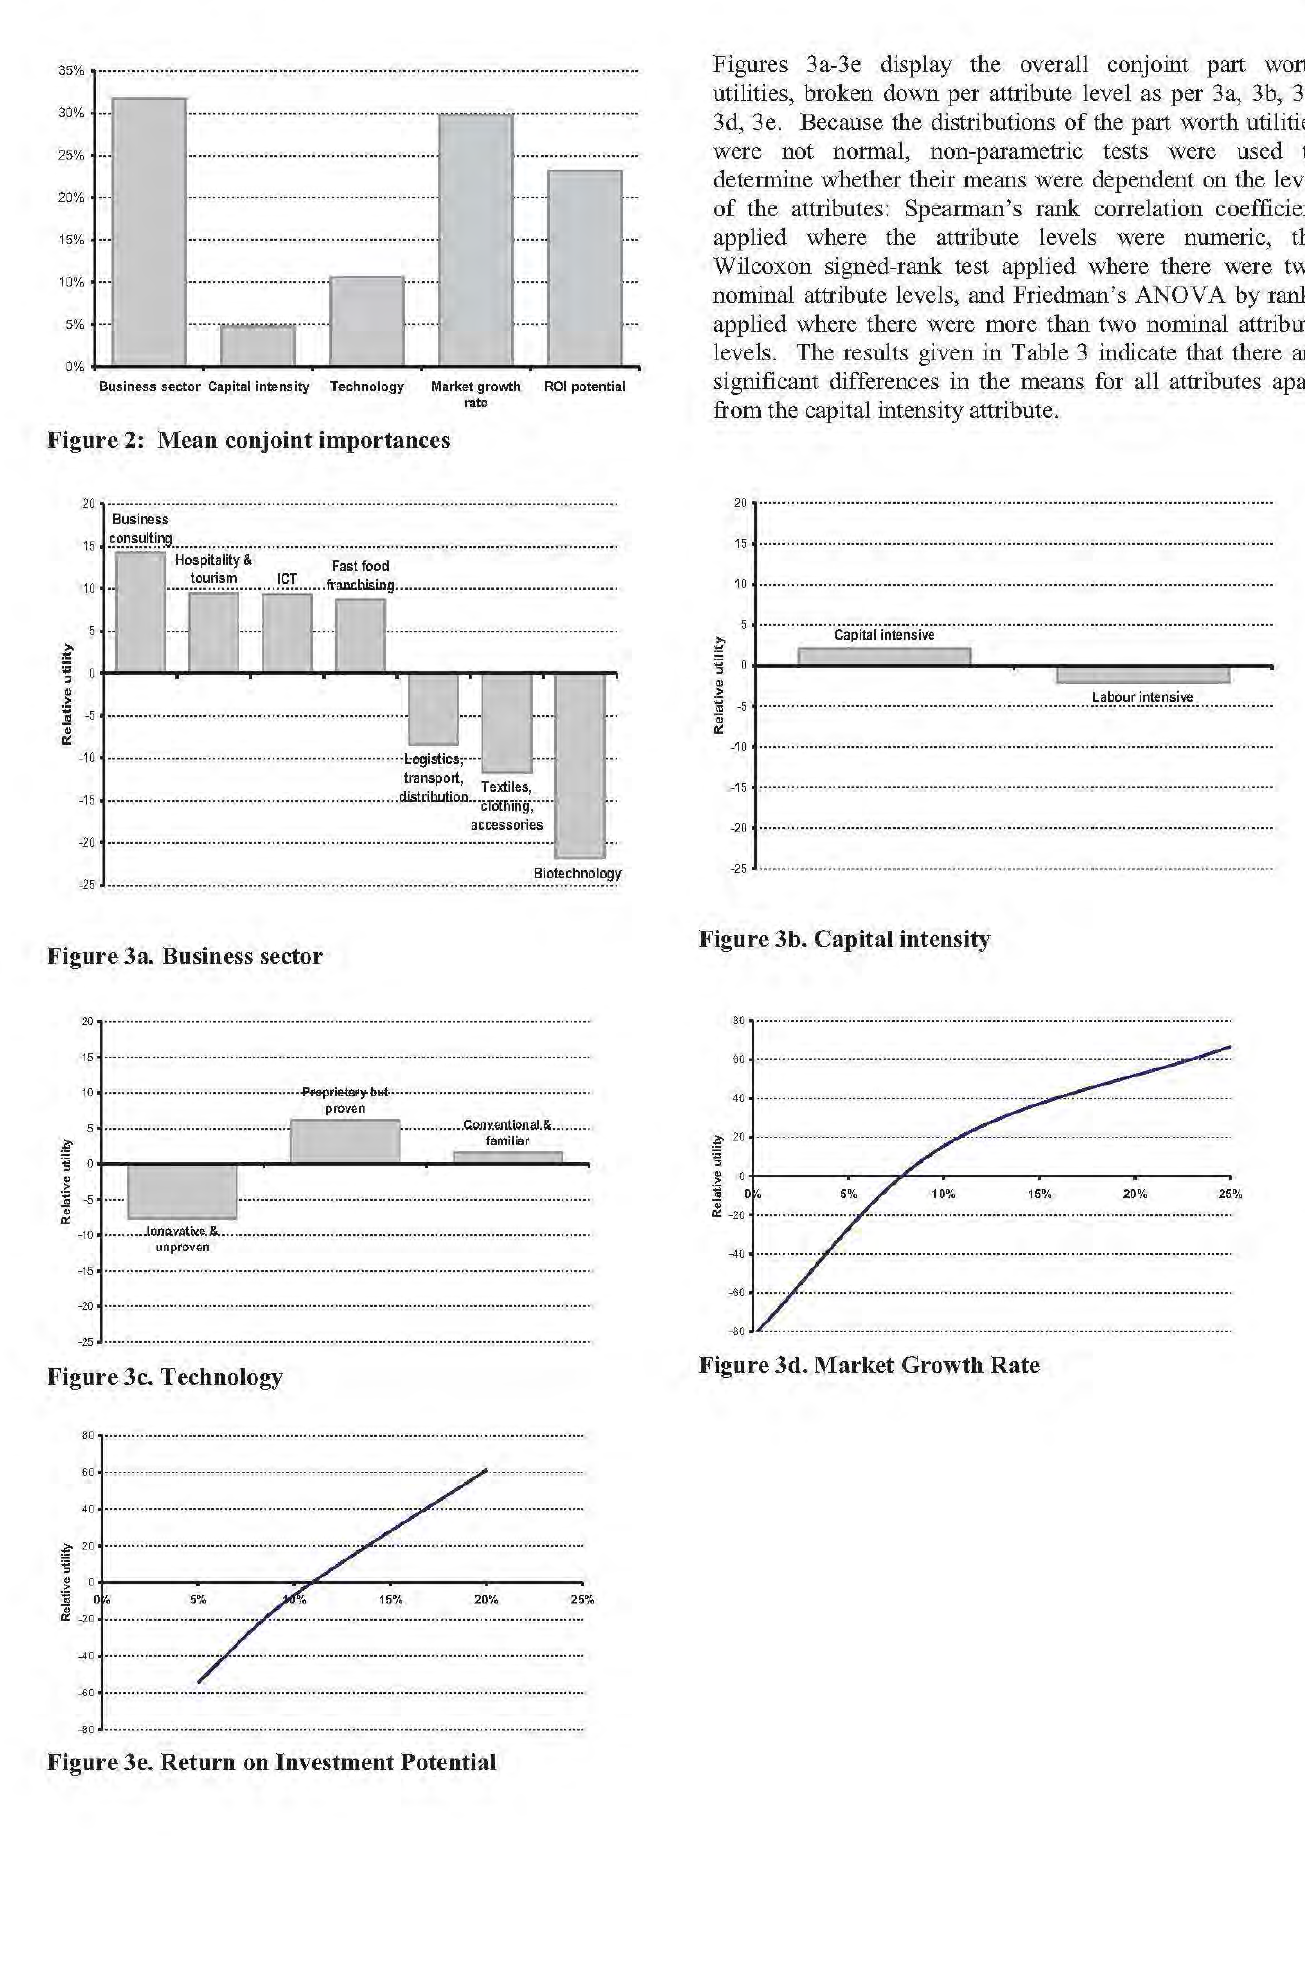
Figure 3e. Return on Investment Potential